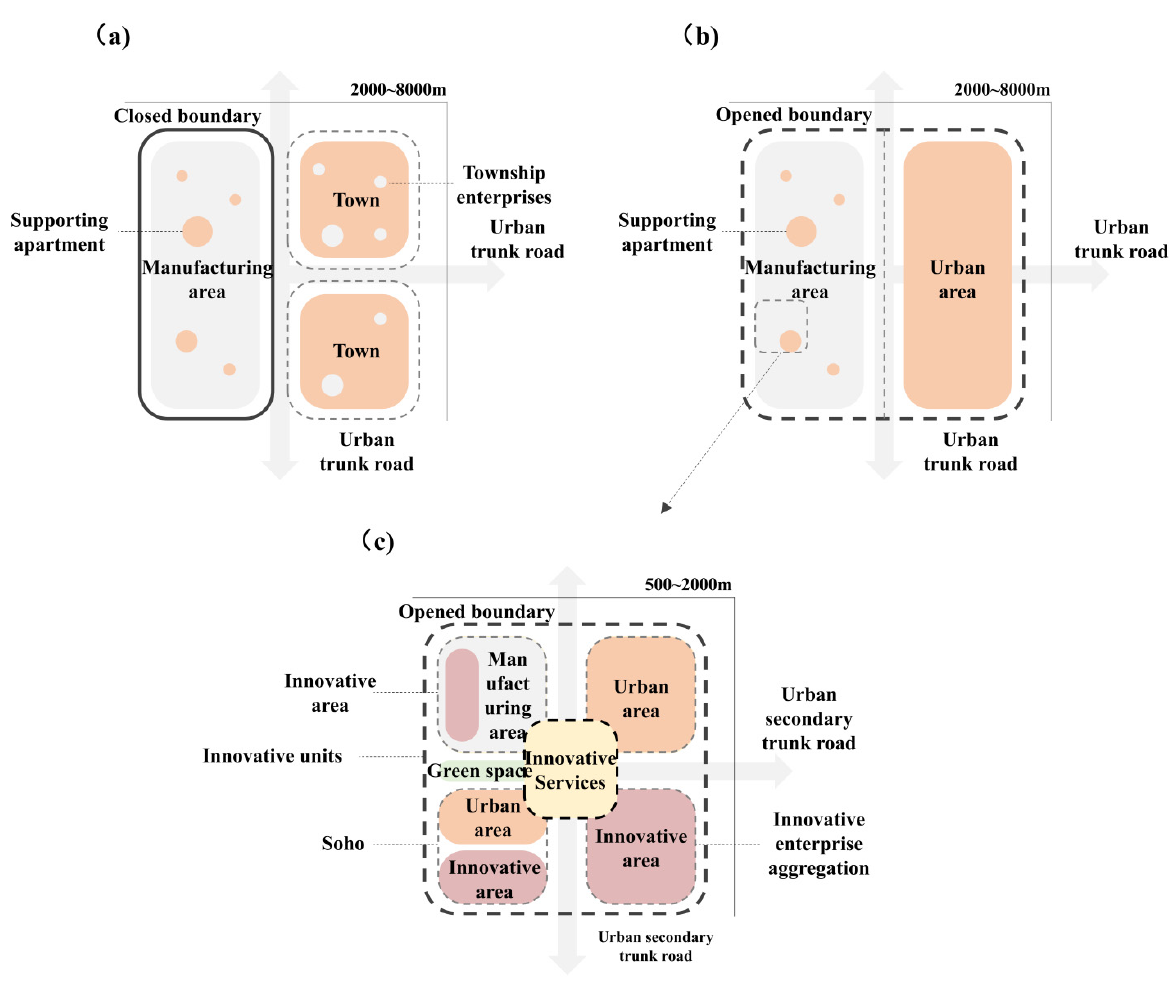
Figure 3. The transition of industrial space land use in development zones. ( a ) Spaces of economic exception; ( b ) Quasi-administrative territory; ( c ) Innovative urban district. Source: Prepared by the authors.